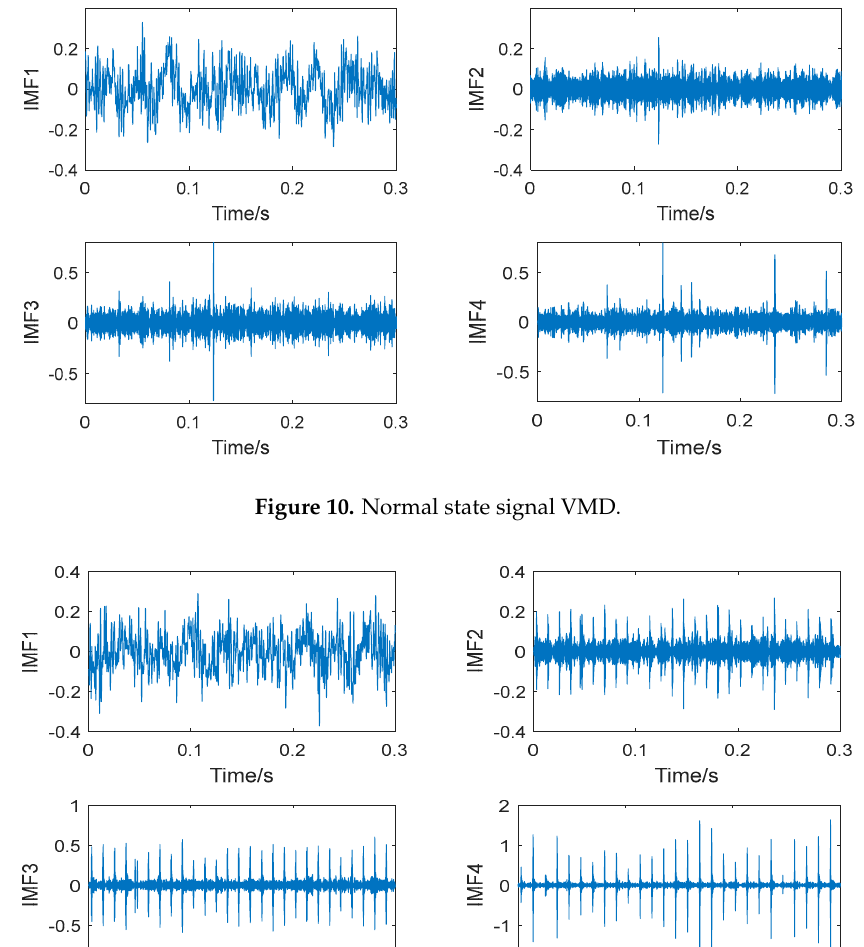
Figure 9. Fault diagnosis process. ApEn : approximate entropy; PSO: particle swarm optimization; CV: cross validation; KELM: kernel extreme learning machine.